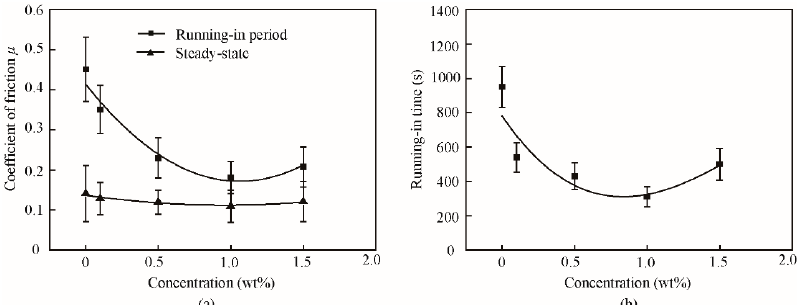
Figure 5. ( a ) friction coefficient and ( b ) running-in time of the base oil and that with different concentrations of lamellar ZrS 2 nanobelt